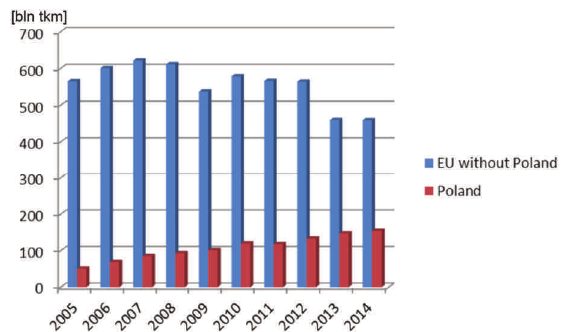
Fig. 5. Number of license excerpts (number of vehicles) of the internation- al freight transport enterprises in the years 2005–2015 (as at 31 December) (diagram based on GITD data